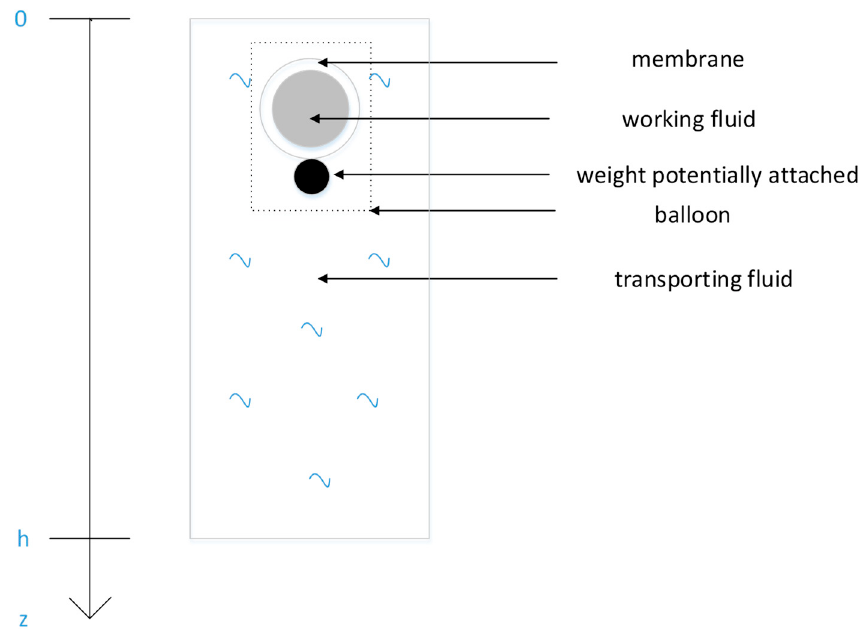
Figure 1. Balloon composed of a working fluid inside a membrane and a potentially attached weight (magnetic marble) inside a column of height h filled with a transporting fluid.